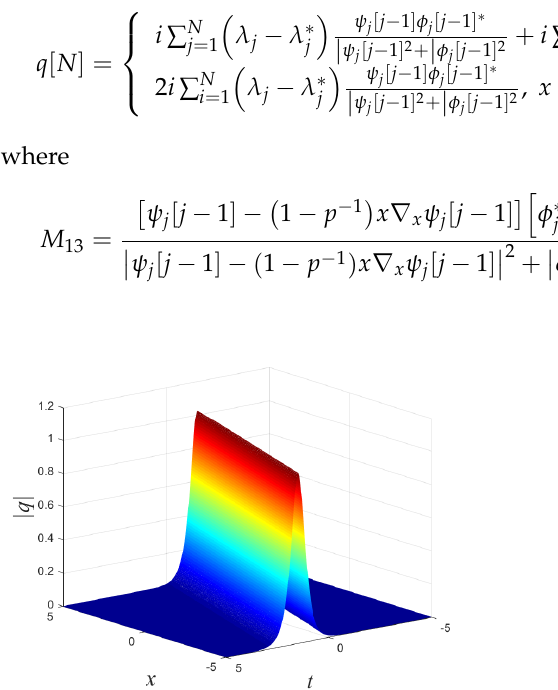
Figure 1. One-soliton solution with ξ = 0.825, η =